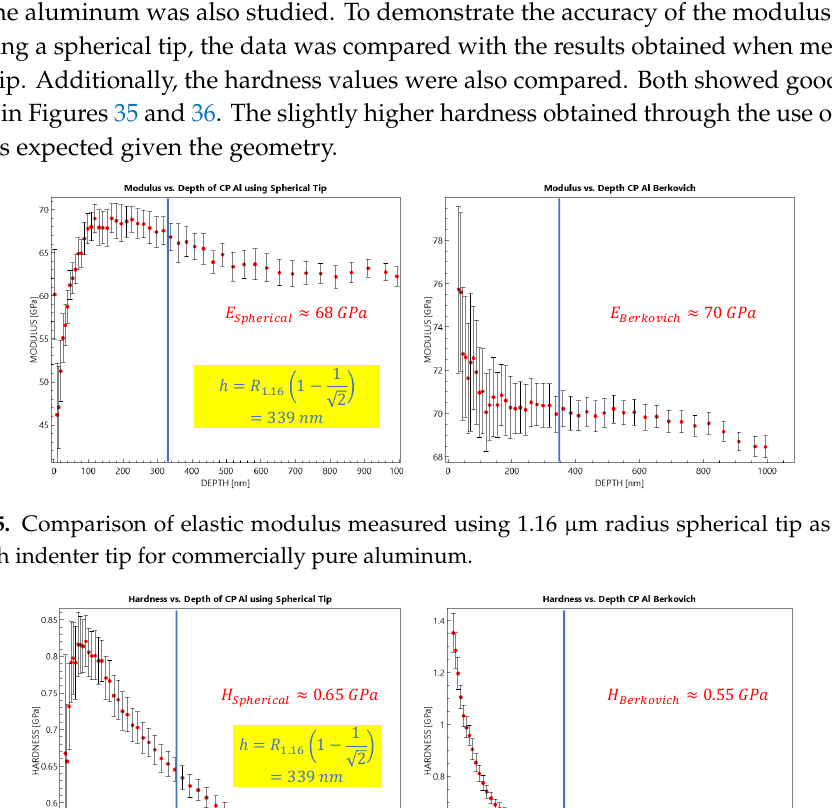
Figure 35. Comparison of elastic modulus measured using 1.16 μ m radius spherical tip as well as Berkovich indenter tip for commercially pure aluminum.